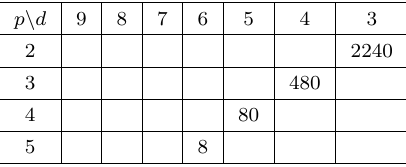
Table 31 . Number of E (5;4) -branes in the p -brane multiplet in d -dimensions [17].